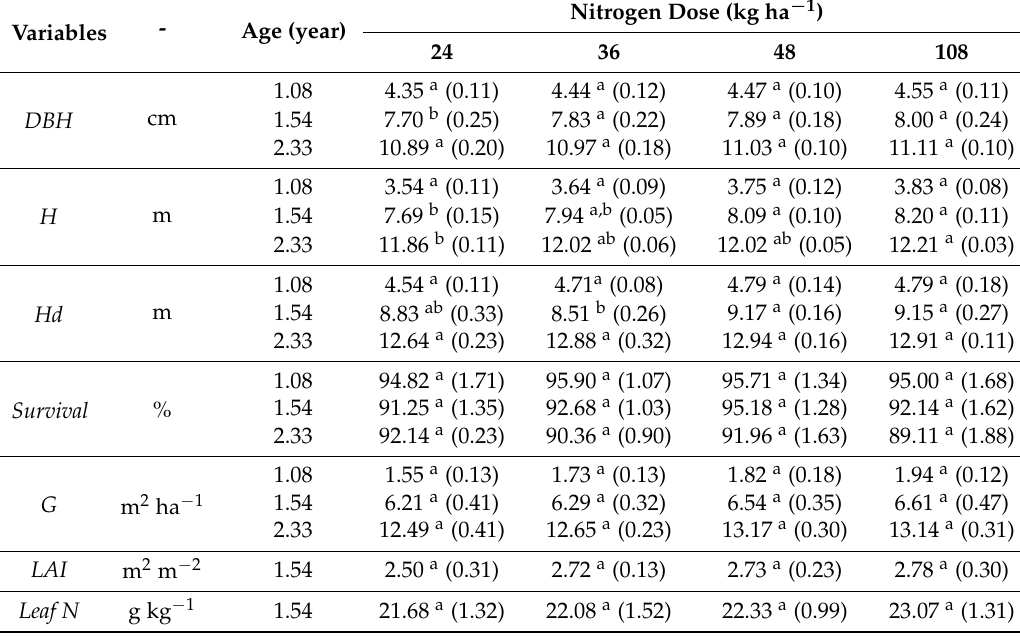
DBH : Diameter at breast height; H : Height; Hd : Dominant height; G : Basal area; LAI : Leaf area index; Leaf N : Foliar N content. Standard errors ( n = 4) are presented inside parentheses. Averages within each sampling period (i.e., each row) followed by same lower-case letter do not differ at 5% by LSD test.